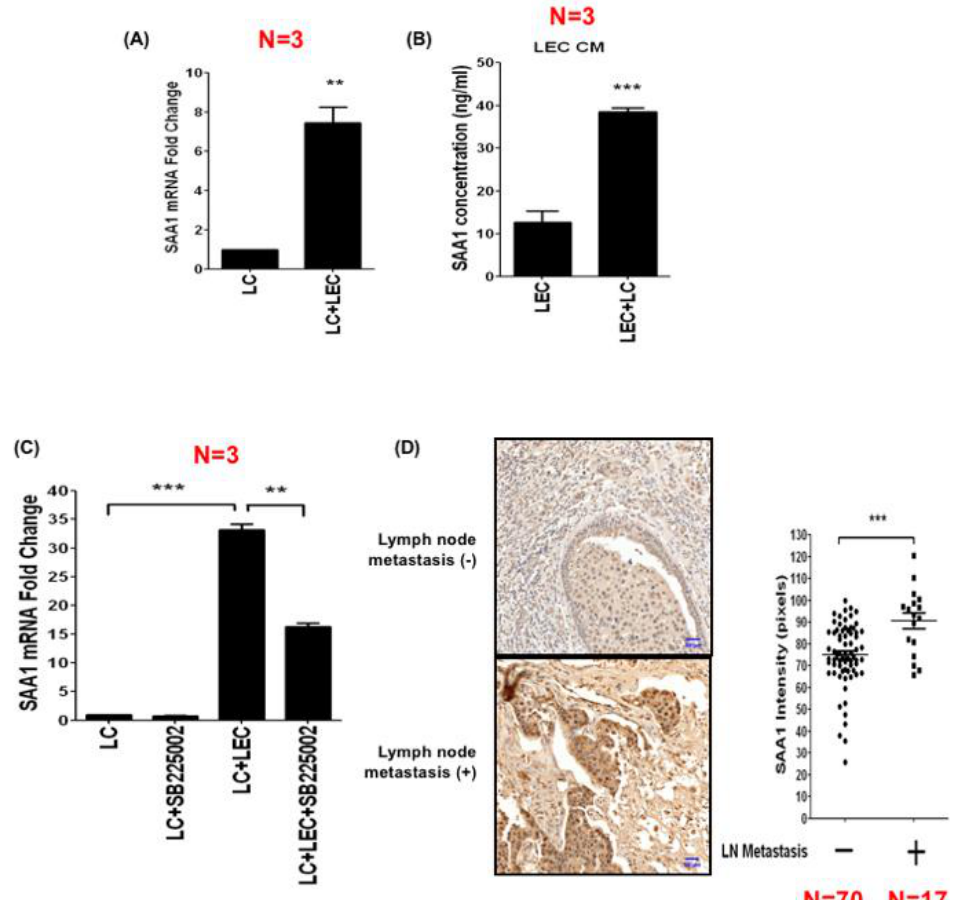
Figure 5. LEC-derived chemokines reciprocally upregulate SAA1 in cancer cells to promote lymphatic invasion. ( A ) The expression of SAA1 in LC cells with or without co-culture with LECs was compared. ( B ) The amount of SAA1 released from LC cells with or without co-culture with LECs was compared. ( C ) Treatment of SB225002 significantly reduced the expression of SAA1 in LC cells co-cultured with LECs, suggesting that LEC-derived chemokines stimulate SAA1 in cancer cells via CXCR2. ( D ) The expression of SAA1 in breast tumors with lymph node metastasis was significantly higher than that of breast tumors without metastasis. Scale bar: 50 μm. * p < 0.05; ** p < 0.01 ; *** p < 0.001.